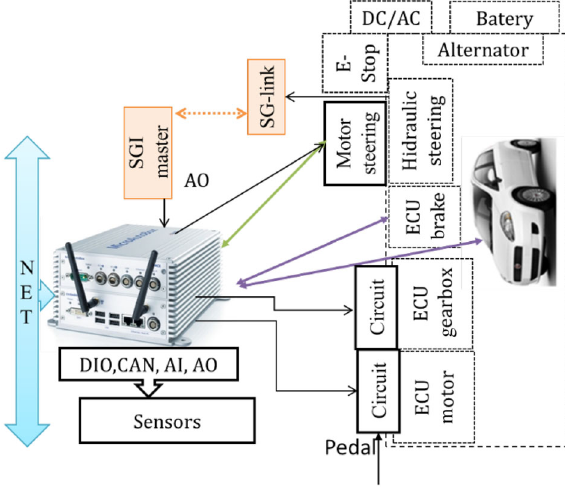
Fig. 3 Hardware architecture of the automation. Communication: Ethernet (blue), RS232 (green), RF (orange), electric signals (black), and CAN (purple)